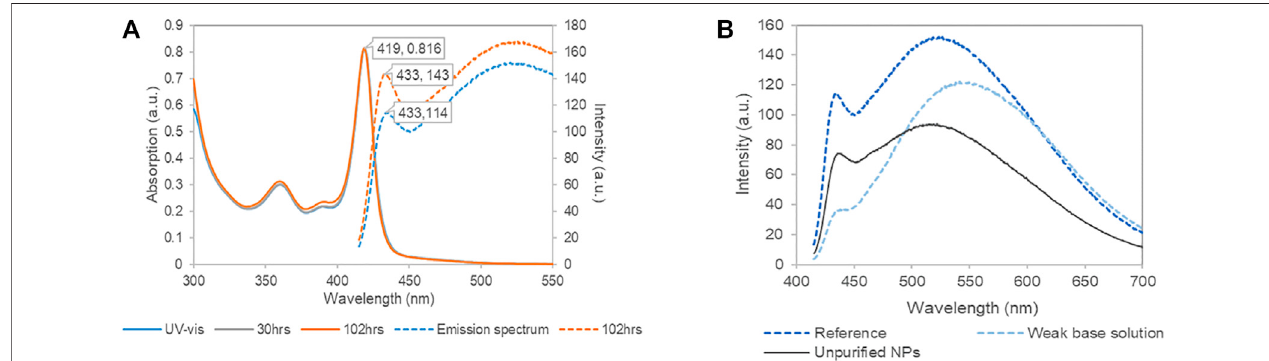
FIGURE1| Optical characteristicsofL-cysteinecapped CdSe nanoparticles(NPs). (A) Temporal changes(4 day interval) ofUV-visabsorptionspectra (solidlines) and photoluminescence spectra with excitation of400 nm (dashed lines) of the puri fi ed NP solution. (B) The photoluminescence spectra in different substrate. The dark